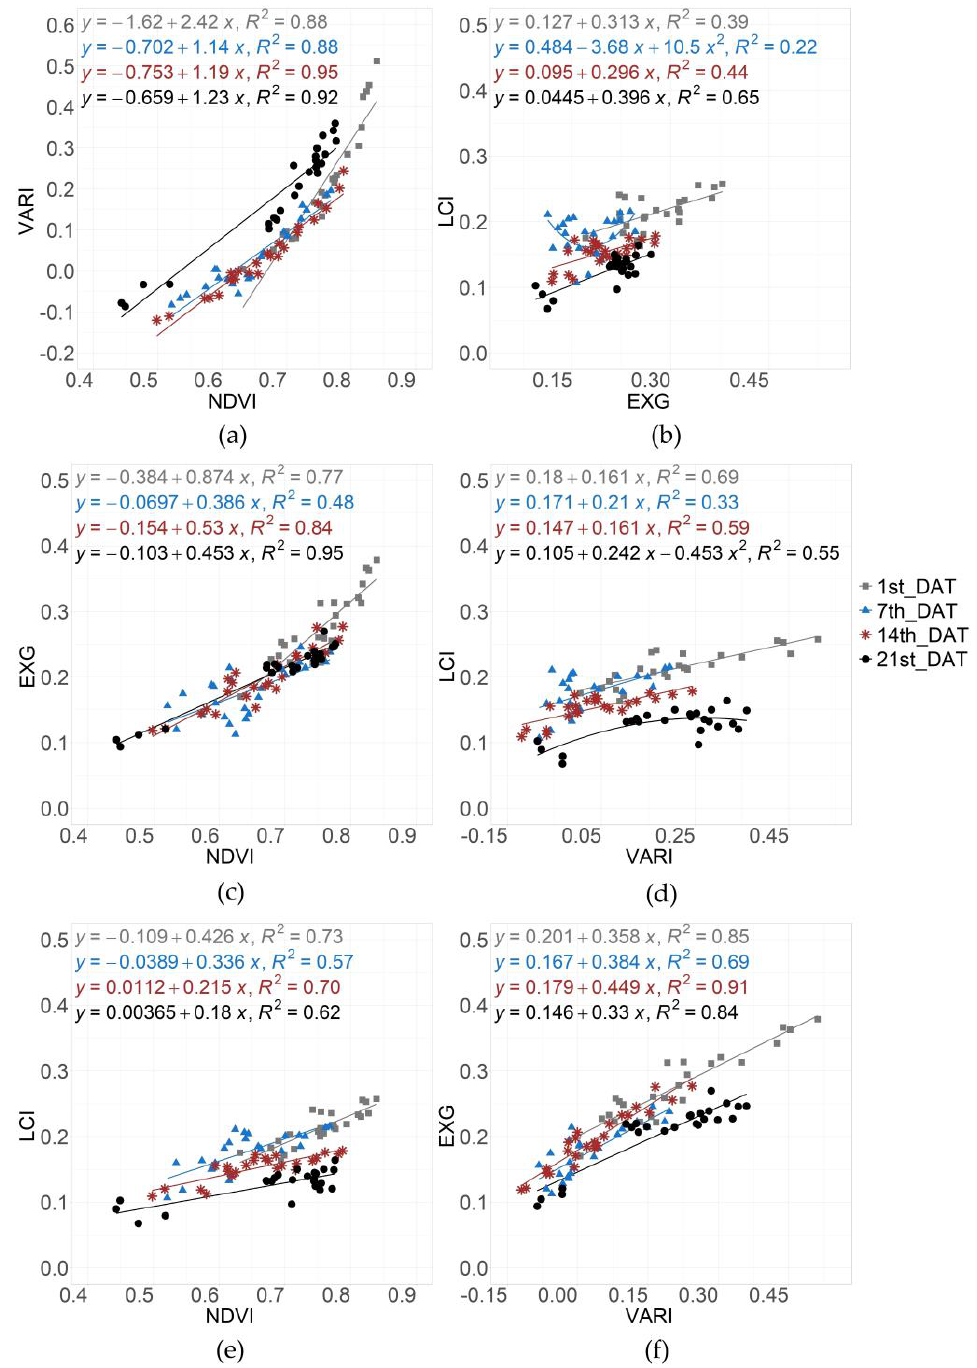
Figure 10. ( a – f ): Relationship between VIs (absolute values) in 2019. Linear and polynomial regres- sion analysis ( p < 0.05).